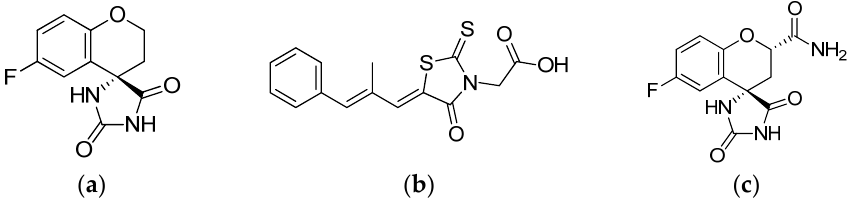
Figure 2. Epalrestat ( a ), Sorbinil ( b ), and Fidarestat ( c ) as the selected examples of aldose reductase inhibitors [26].